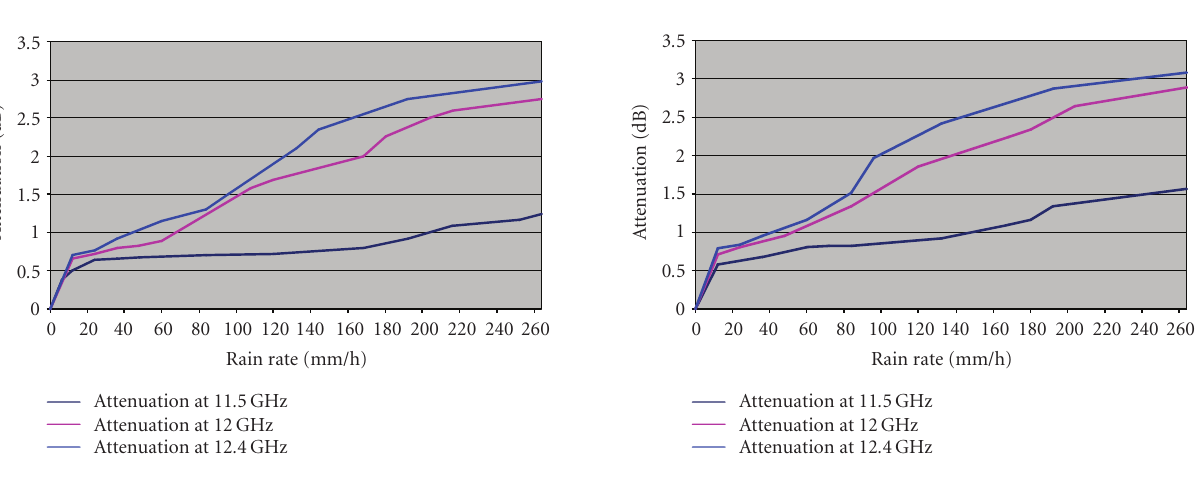
Figure 4: The attenuation versus rain rate at elevation angle 24 ◦ via three frequencies.